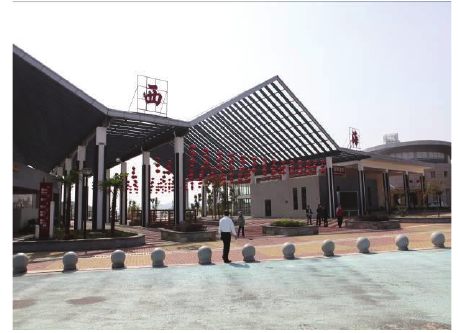
Figure 11: Glass roofs at the entrance of the visitor